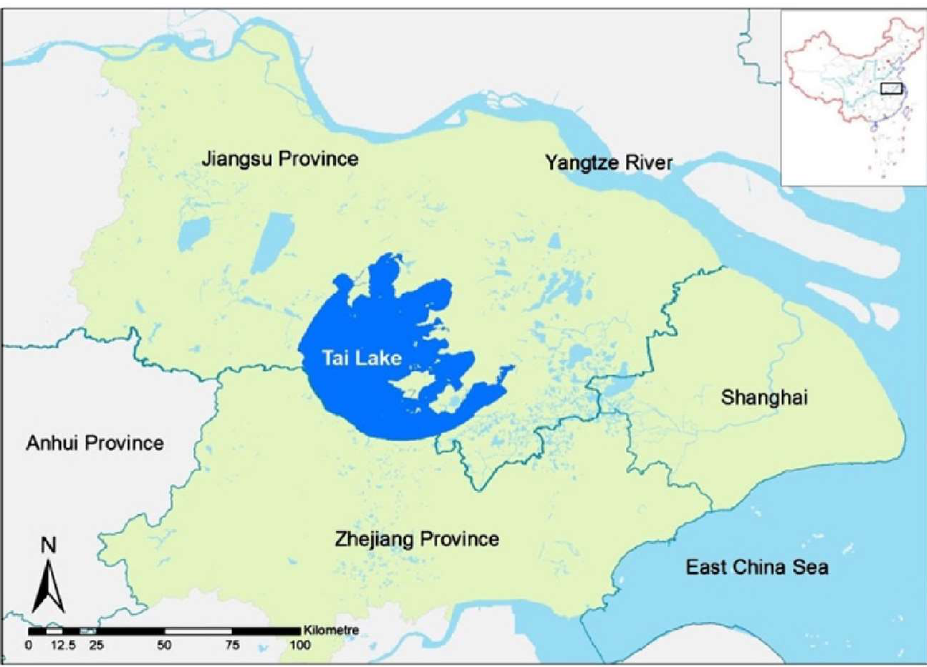
Figure 1. Location and area of Lake Taihu.